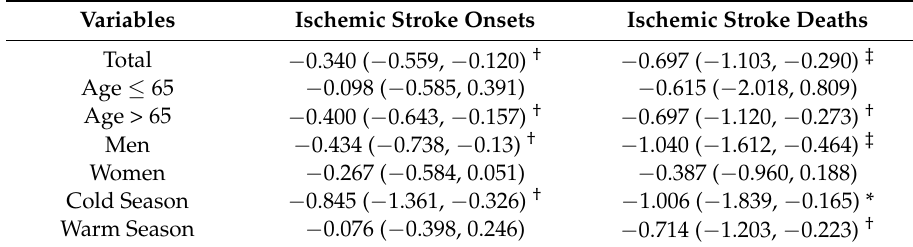
Table 1. Subgroup analyses of the associations between ambient O 3 levels and daily ischemic stroke onsets and deaths modifying by age, gender and seasons. Variables